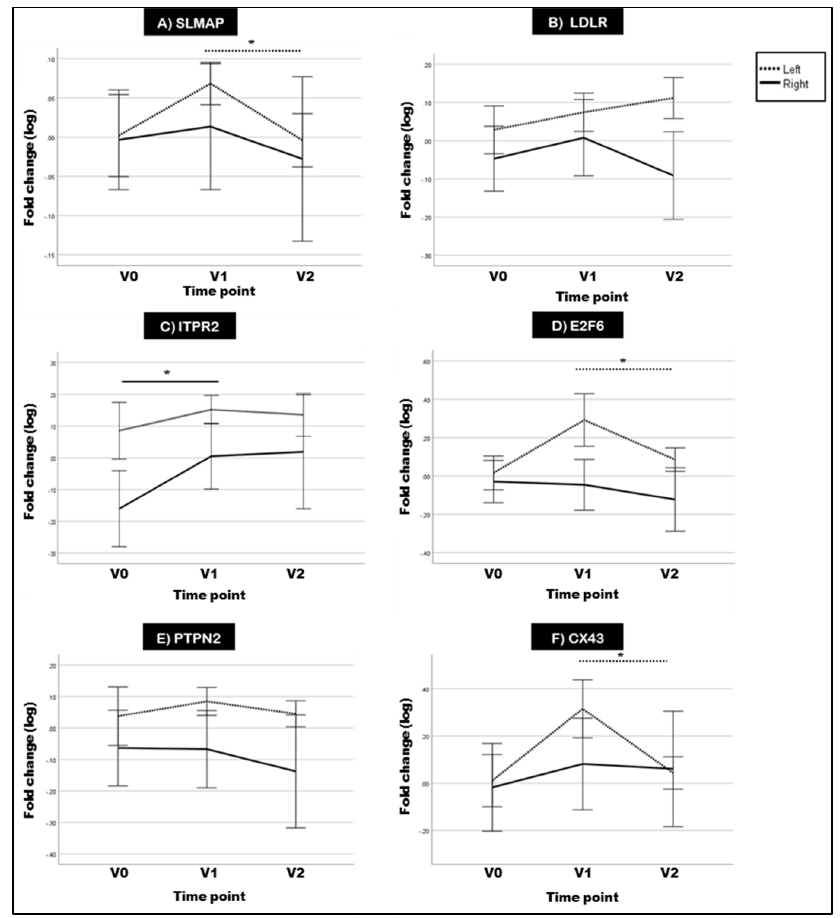
Figure 5. Mean log fold change of SLMAP ( A ), LDLR ( B ), ITPR2 ( C ), E2F6 ( D ), PTPN ( E ) and CX43 ( GJA1 ) (F) expression in the blood of right- (n = 9) and left-sided (n = 16) BC patients sampled at diagnosis (V0), immediately after radiotherapy (V1) and 6 months after radiotherapy (V2). Data are presented as mean log fold changes in gene expression normalized to TBP ± SEM. Displayed significance values were calculated using observed log expression fold changes (* = p -value < 0.05). Statistical analysis was performed using SPSS generalized estimating equations module and multiple comparison correction was performed using